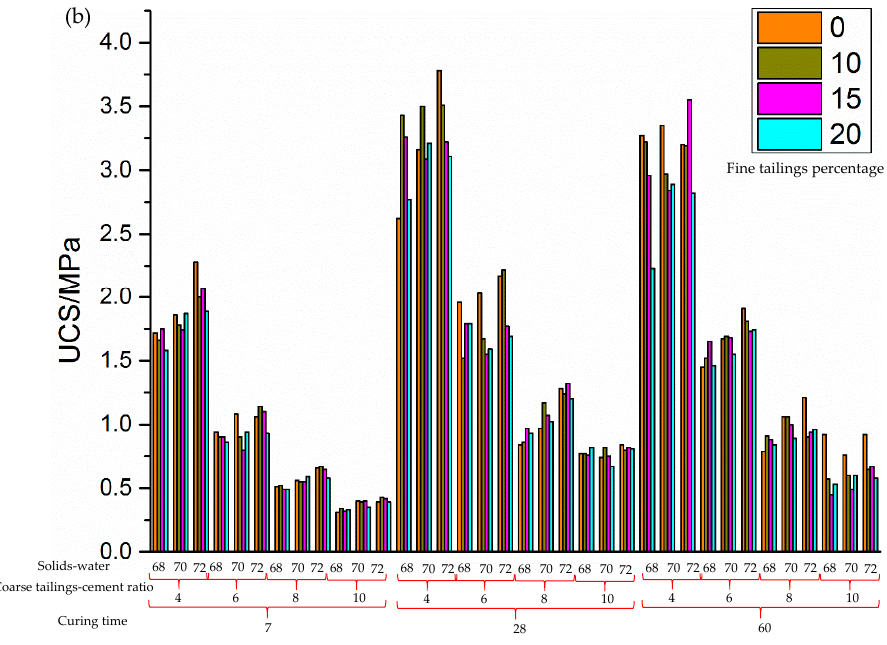
Figure 4. UCS test results of CPB in 4D. ( a ) 1# cement; ( b ) 2# cement.